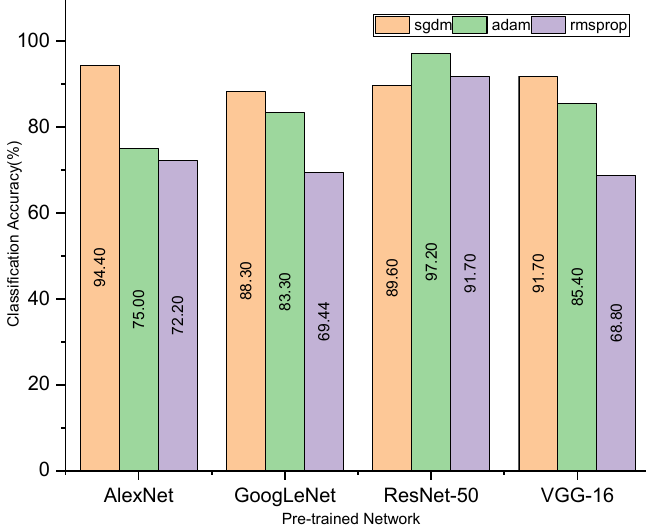
Figure 9. Performance of pretrained network for various solver.